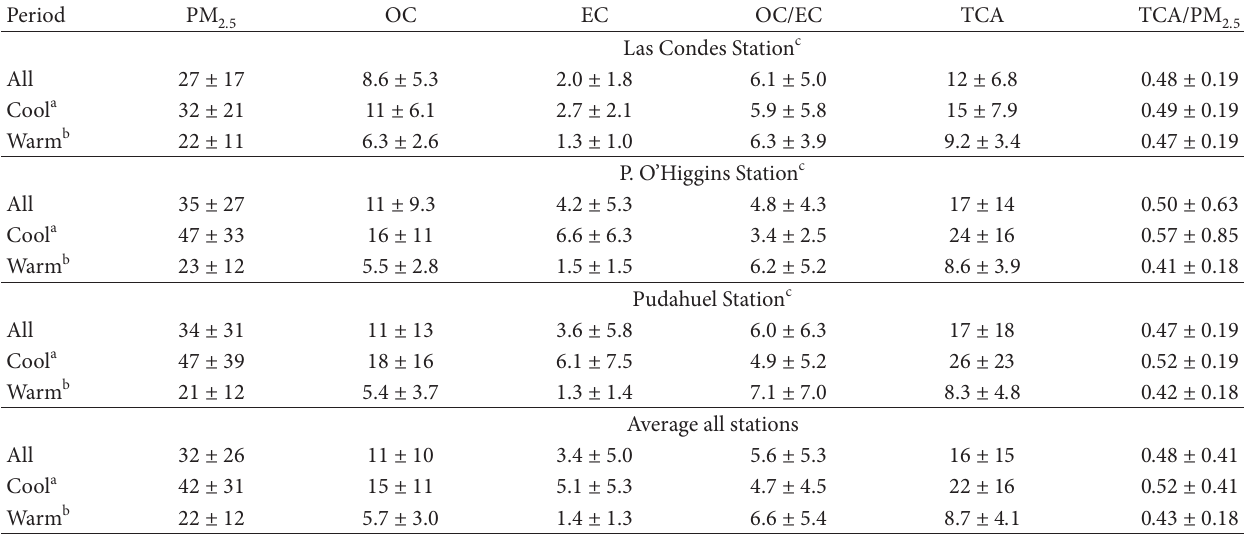
Table 2: Statistical hourly mass concentrations of PM 2.5 , OC, EC, and TCA in 𝜇 gm − 3 at the three sampling